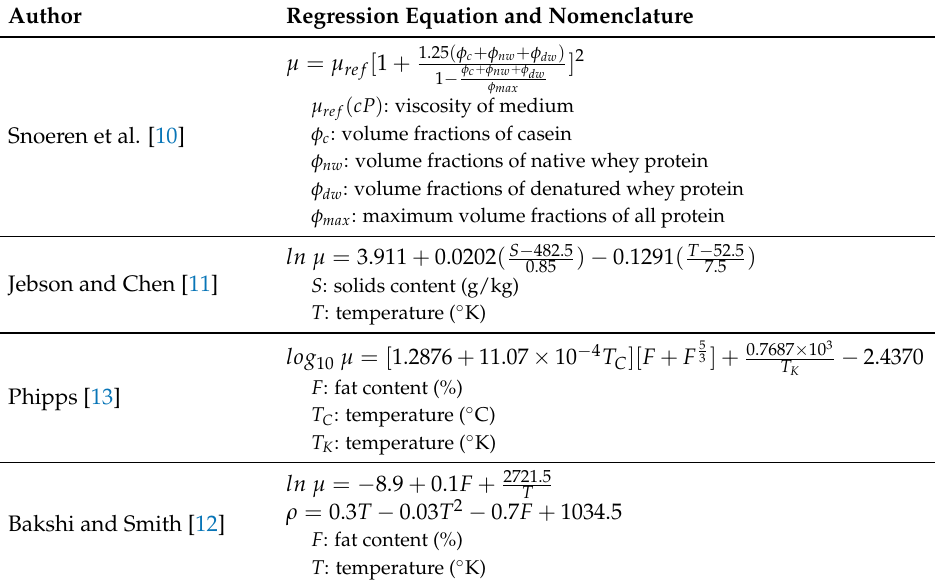
Table 1. Regression equations for bovine viscosity and